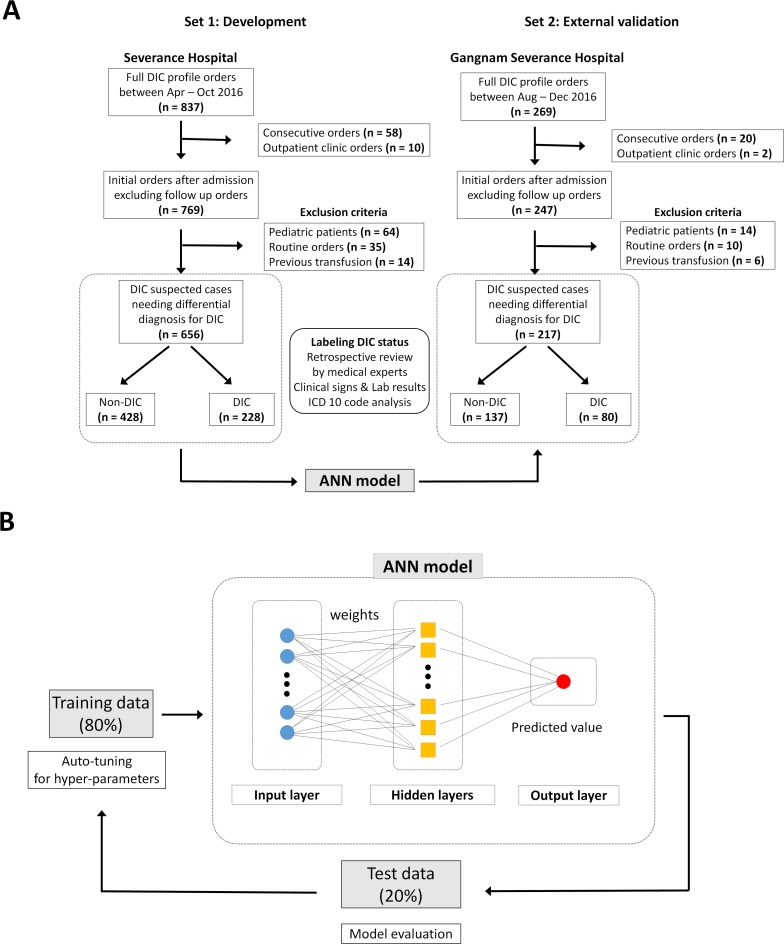
Schematic representation of patient enrollment and development of the artificial neural network (ANN) model.(A) Full DIC profile was defined as all laboratory results including complete blood count with differential counts, global coagulation tests (PT, PT % activity, international normalized ratio [INR], activated partial thromboplastin time [aPTT], and thrombin time), fibrinogen, D-dimer, FDP, and anti-thrombin III. The external validation hospital used different DIC profile: protein C was included instead of FDP, and RUO parameters were not provided. (B) ANN model for DIC diagnosis. In the training phase, the development set (n = 656) was randomly split into training and test sets in 80:20 ratio and hyper-parameters were determined for an optimal modeling. All layers have 32 nodes with an input-layer and two-hidden layers. The relative importance of input features was calculated based on the ‘Connection Weight’ approach, after the ANN model was established.